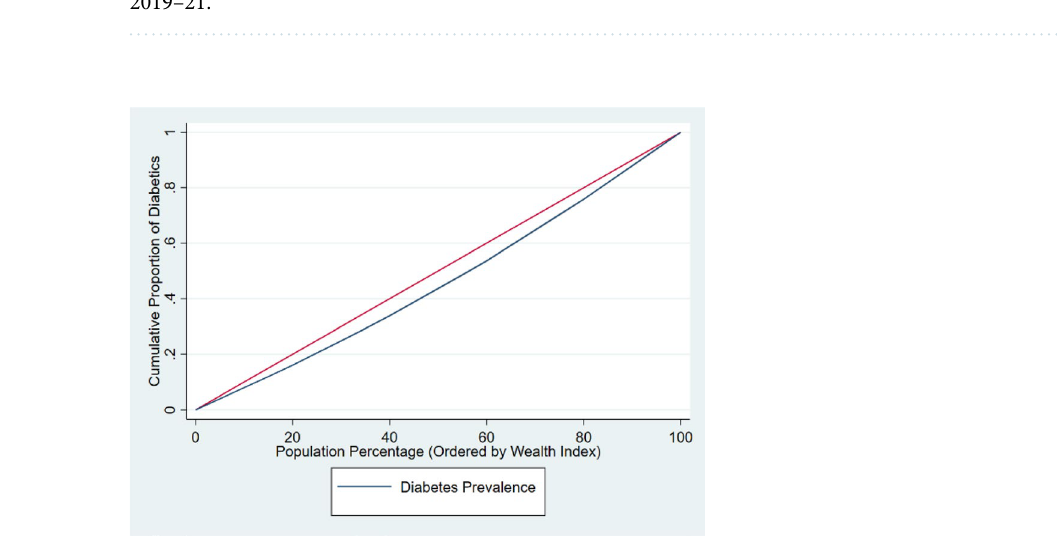
Table 3. Adjusted concentration indices for diabetes and for ATC among those with diabetes in India, 2019–21.